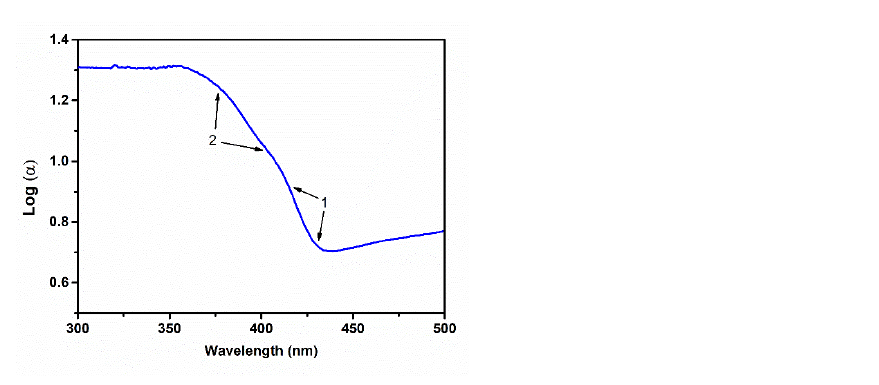
Figure 6. Photoabsorption curves for TiO 2 material showing the presence of direct (1—rapid increase in α with the increase in the incident photon energy) and indirect band gap (2—slow increase in α with the increase in the incident photon energy).